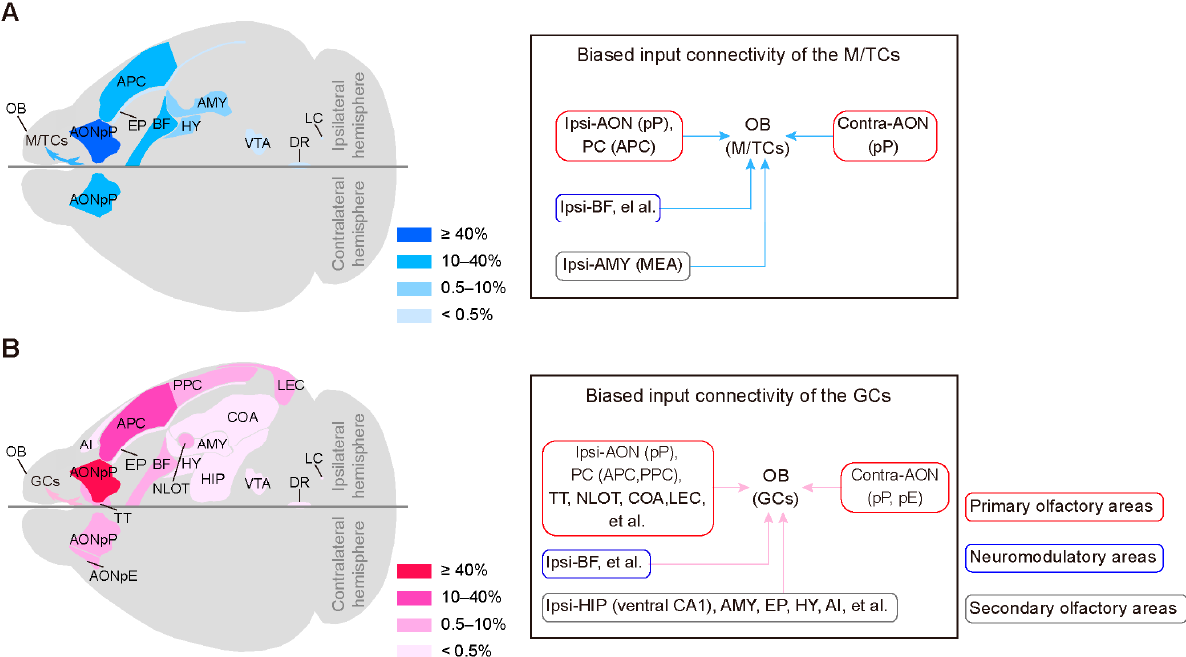
Figure 7 . Summary of the major centrifugal input regions of the OB. ( A,B ) Schematic representation (left) and subnetwork organization (right) of the centrifugal input targeting M/TCs ( A ) and GCs ( B ). The color transparency represents the percentage of input to the MTCs (blue) and GCs (red). AON, anterior olfactory nucleus; AONpP, anterior olfactory nucleus pars principalis; AONpE, anterior olfactory nucleus pars externa; PC, piriform cortex; APC, anterior piriform cortex; PPC, posterior piriform cortex; TT, taenia tecta, NLOT, nucleus of the lateral olfactory tract; COA, cortical amygdalar nucleus; LEC, lateral entorhinal cortex, BF, basal forebrain; HIP, hippocampal region; AMY, amygdalar area, MEA, medial amygdalar nucleus; EP, endopiriform nucleus; HY, hypothalamus; AI, agranular insular cortex.